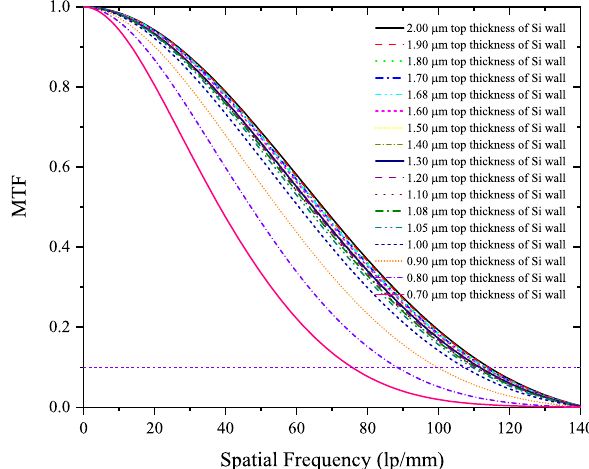
Figure 6. MTFs for the structured CsI(Tl) screens with different t Si .